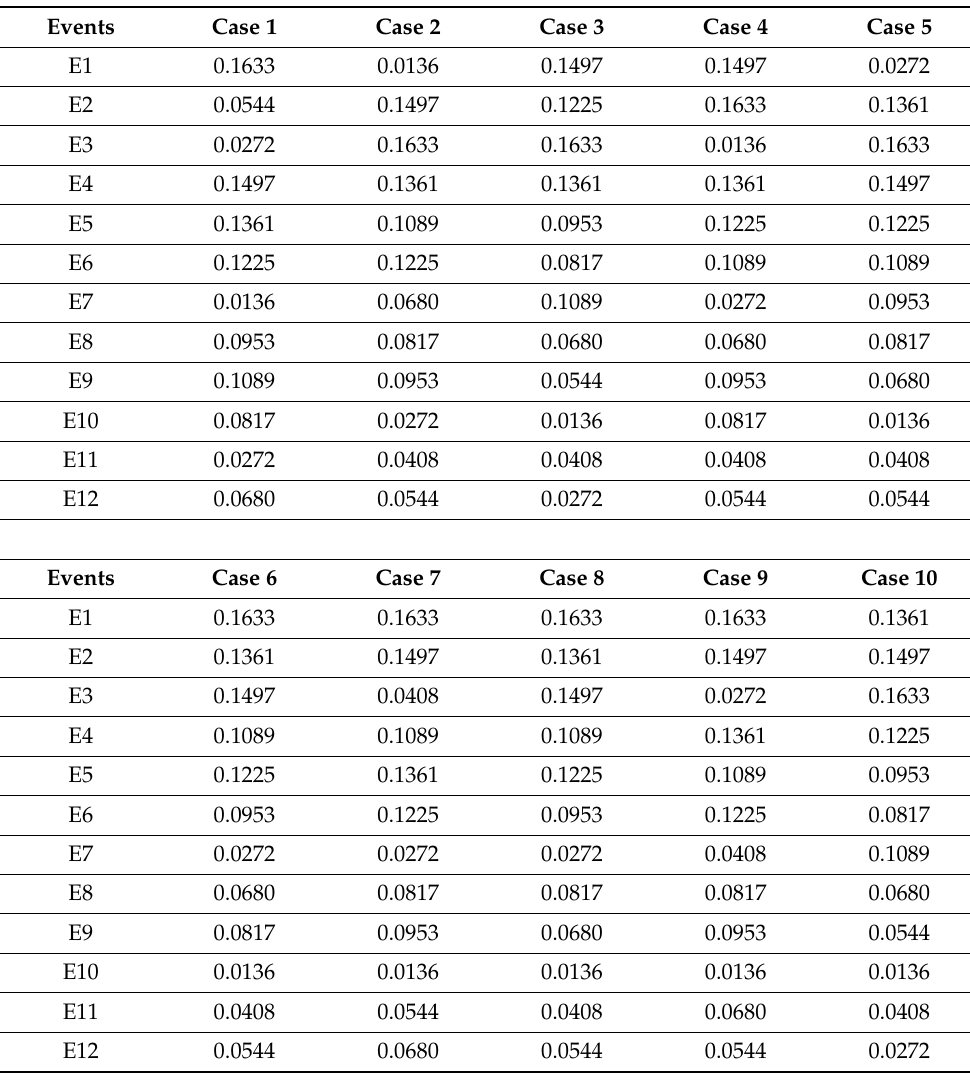
Table 3. Table of case study